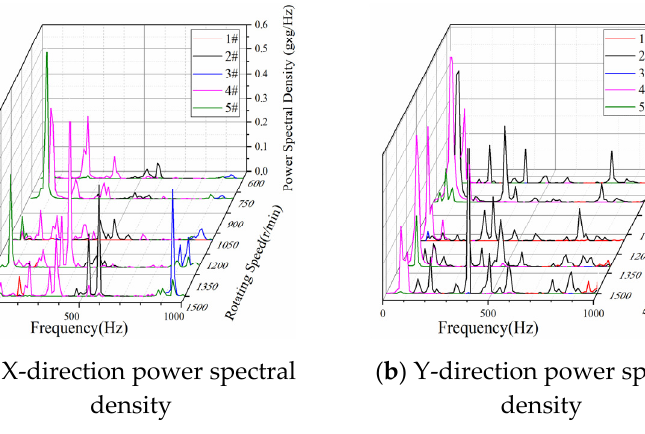
Figure 4. Frequency Domain Analysis of the Exhaust Tube Vibration.